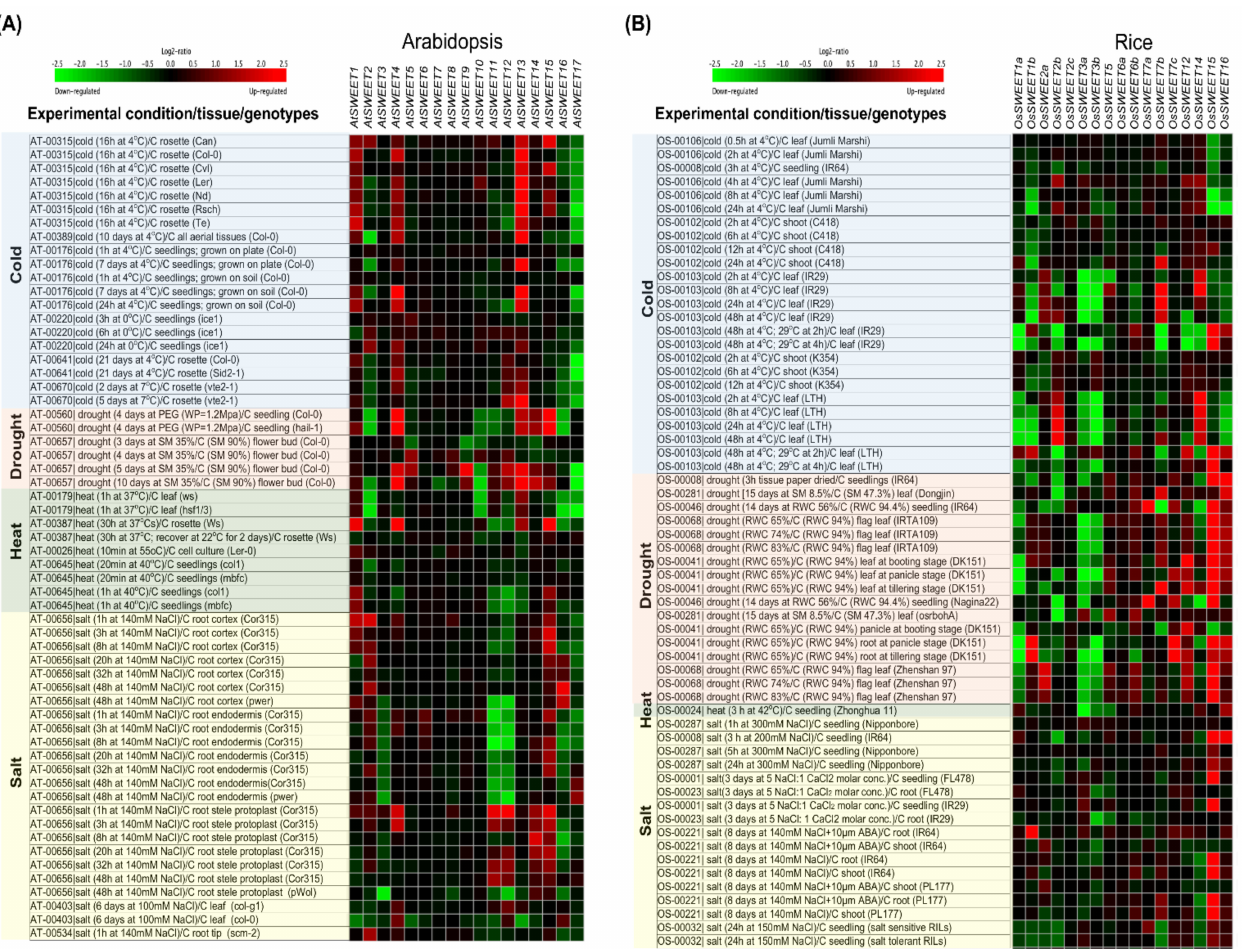
Figure 4. Heat maps representing SWEET gene expression patterns in ( A ) Arabidopsis and ( B ) rice under abiotic stresses (cold, drought, heat and salt). Heatmap was constructed from the data obtained from the Genevestigator database containing different experiments. [Red = up-regulation and Green = down-regulation of